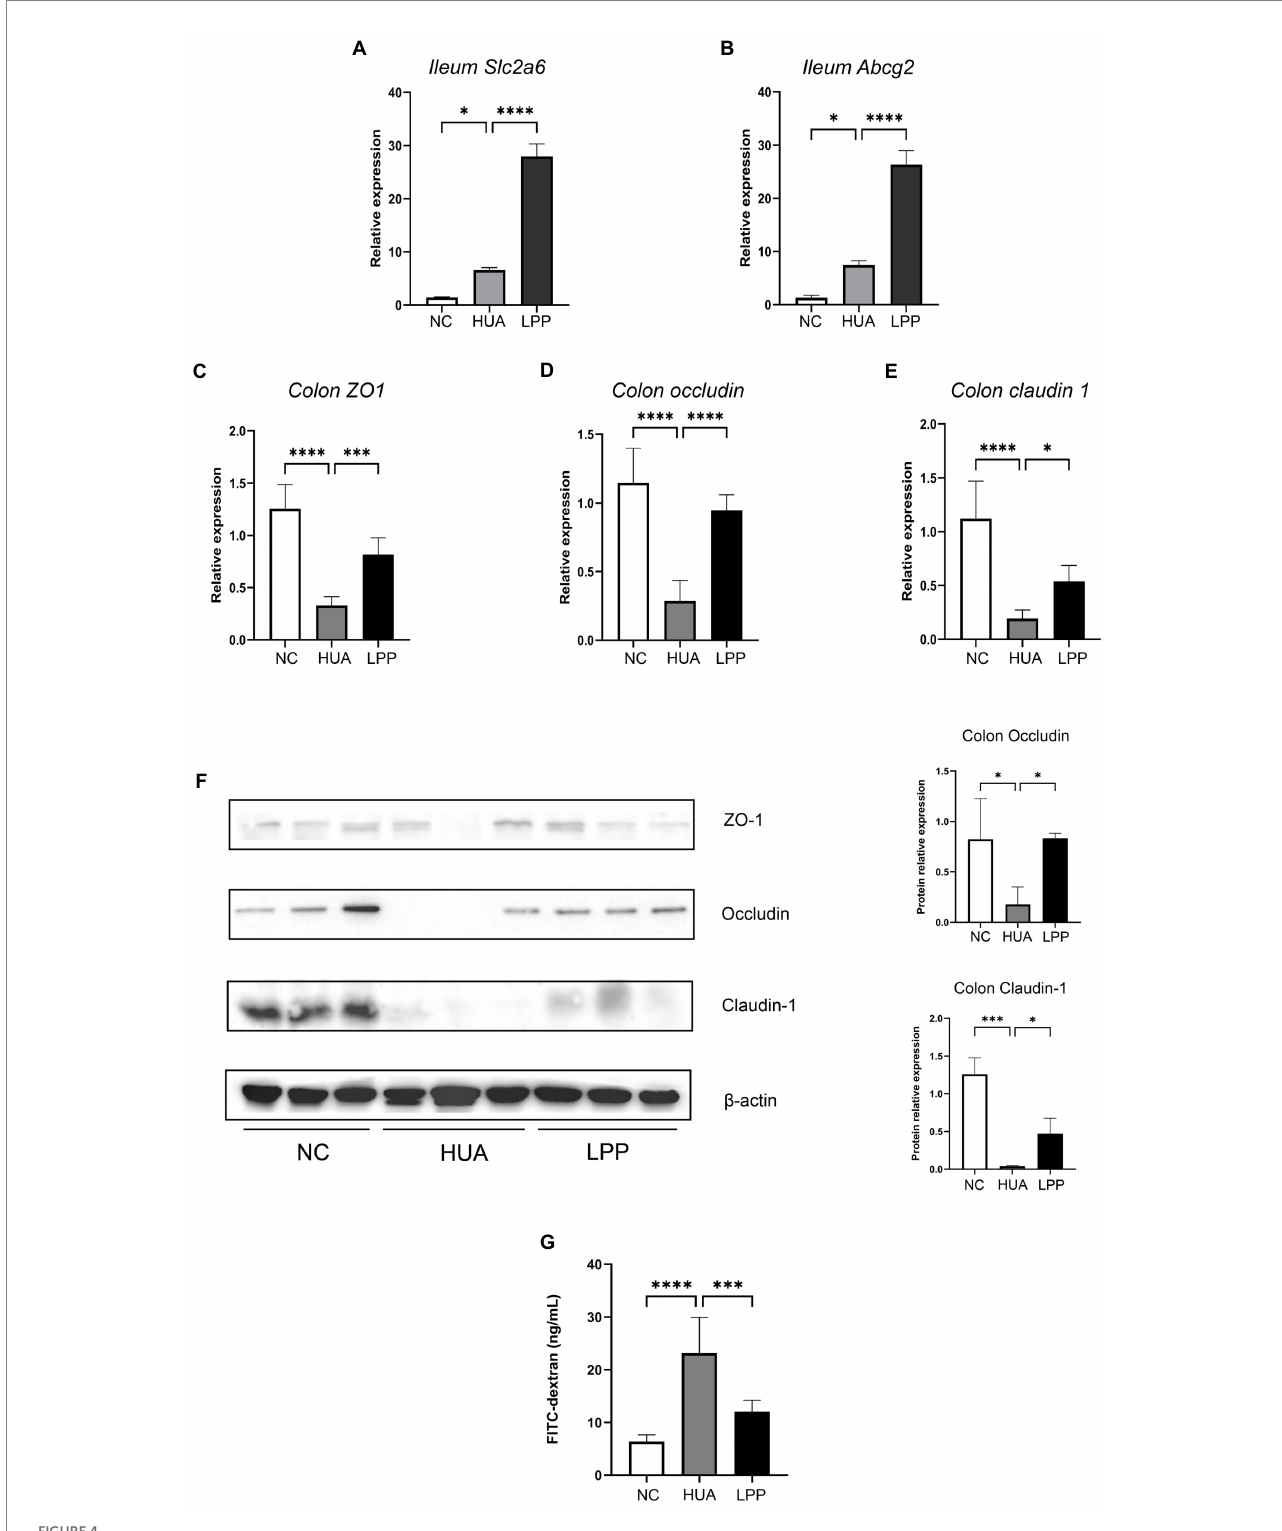
FIGURE 4 Effect of LPP on expression of tight junction protein and transporters in intestine. (A,B) Relative expression of Slc2a6 and Abcg2 mRNA in ileum tissue normalized by β -actin ( n = 6 pre group). (C–E) Relative expression of TJ proteins ( ZO1, occludin, claudin1 ) mRNA in colon tissue normalized by β -actin ( n = 6 per group). (F) Representative western blotting images of ZO-1, Occludin and Claudin-1 in renal tissue. The protein expressions were quantitated by Image J software and normalized by β -actin ( n = 3 per group). (G) FITC-dextran detected in serum of mice from NC, HUA and LPP groups after administration with oral gavage. Bars are means ± SD, p < 0.05 was set as the threshold for significance by one-way ANOVA followed by post hoc comparisons using Tukey’s test for multiple groups’ comparisons, * p < 0.05; ** p < 0.01; *** p < 0.001; **** p <